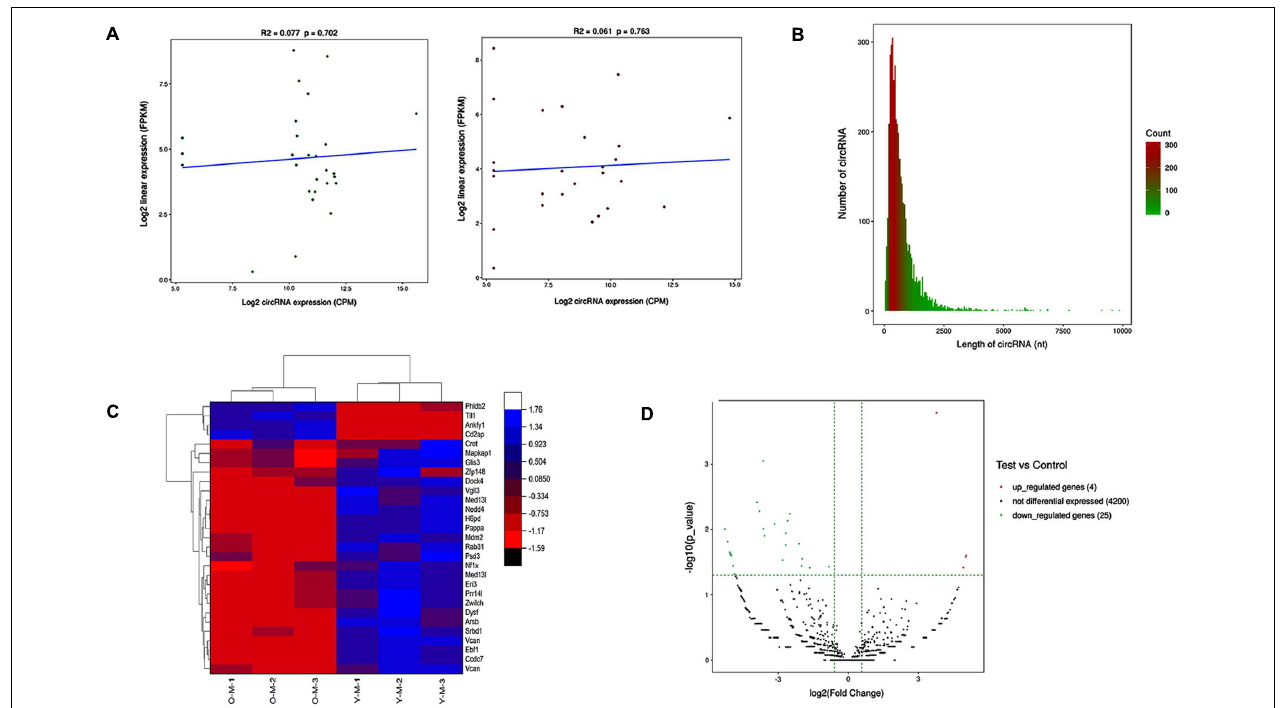
FIGURE 2 | Results of high-throughput sequencing. (A) Expression correlation test of inter-sample. Young and old MSCs derived from 1–2- to 15–18-month-old rats were used, and three samples were contained in each group. The relativity between gene expression levels in the three samples indicated biological repetition. (B) CircRNA length distribution. It was predicted that approximately 95% of circRNAs had limited length of less than 2,000 nt. (C) Heatmap showing differential expression profiles of circRNAs between the two study groups and the homogeneity within each group. (D) Volcano map of differentially expressed circRNAs. The green and red dots in the figure represent the differentially expressed circRNAs, which are statistically significant. The upregulated circRNAs are represented by red dots, and the green dots denote the downregulated circRNAs.